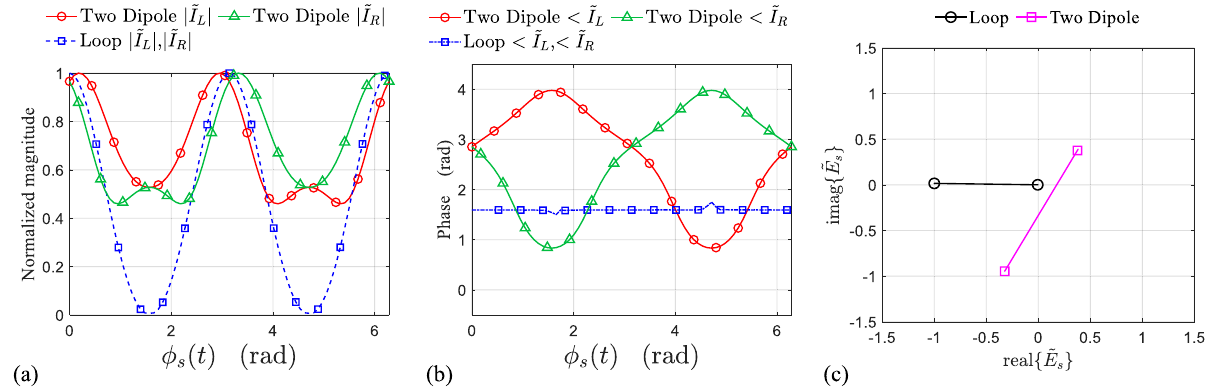
Figure 6. ( a ) Normalized magnitude, ( b ) phase of left-side and right-side induced currents on the two symmetrically rotating dipoles and the rectangular loop. ( c ) IQ constellation of the time-varying complex envelope of the normalized backscattered field from symmetrically rotating loop and two symmetrically rotating dipole. All the data are obtained in